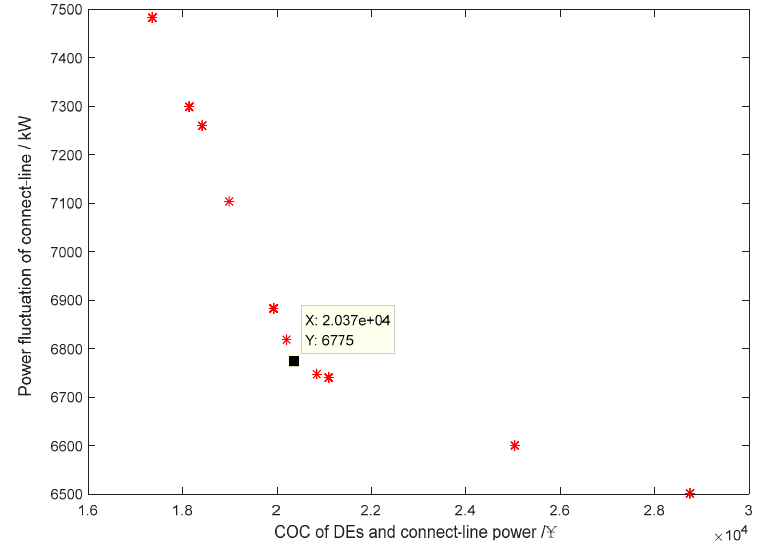
Figure 11. Pareto front of the source-grid-load level.